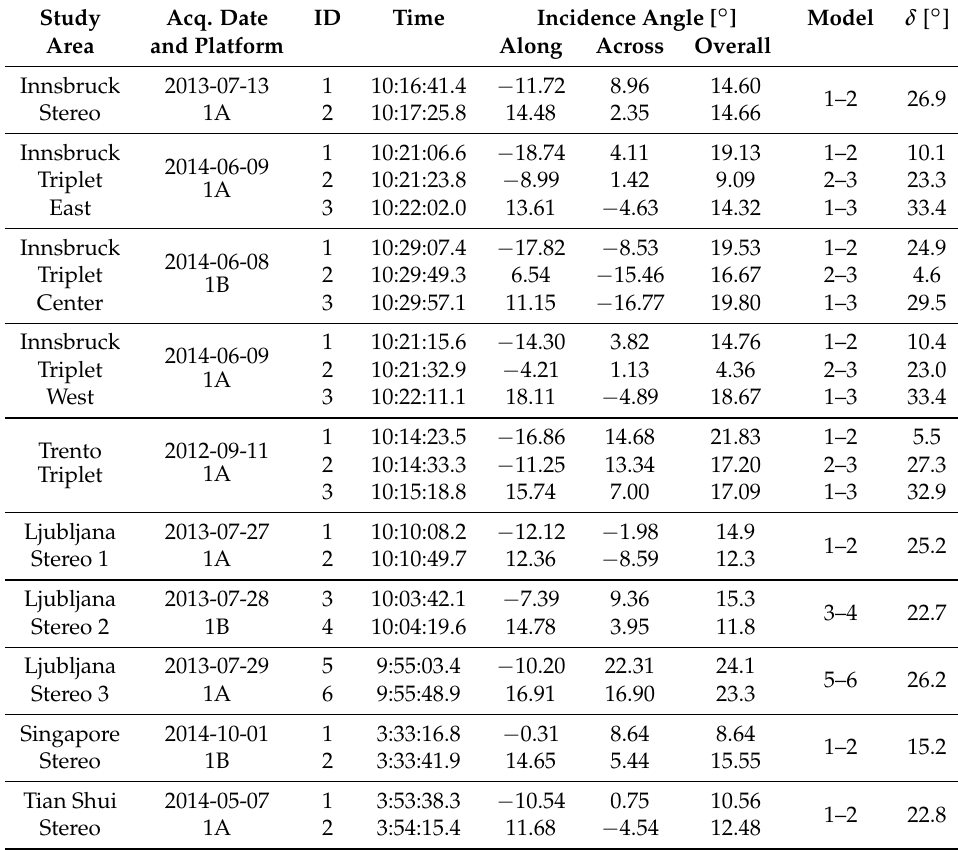
Table 1. Acquisition parameters for the Pléiades satellite images over the study areas (with δ being the convergence angle based on Equation